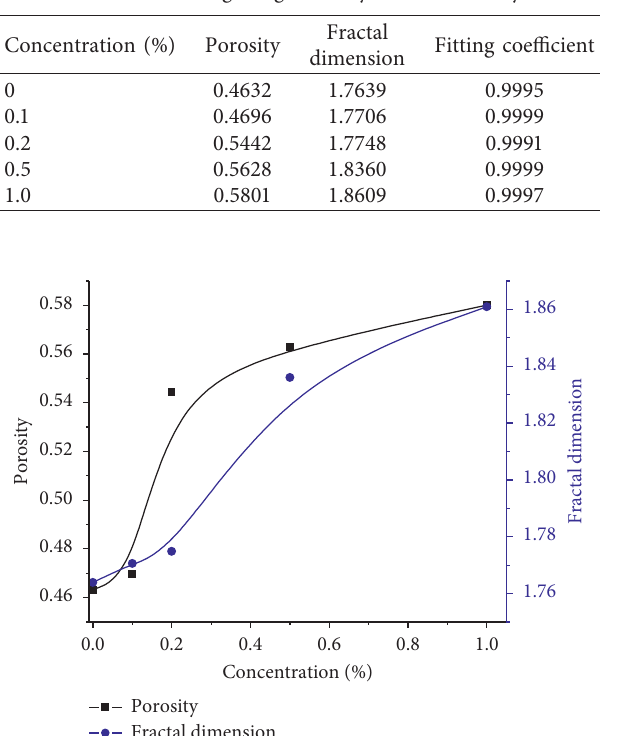
Figure 7: Original image and binary image. (a) Original image. (b) Binary image. Table 5: Processing image data by MATLAB analysis.